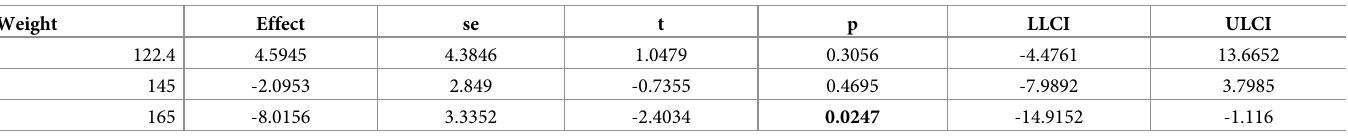
Table 5. Conditional effects monthly CB use at values of the